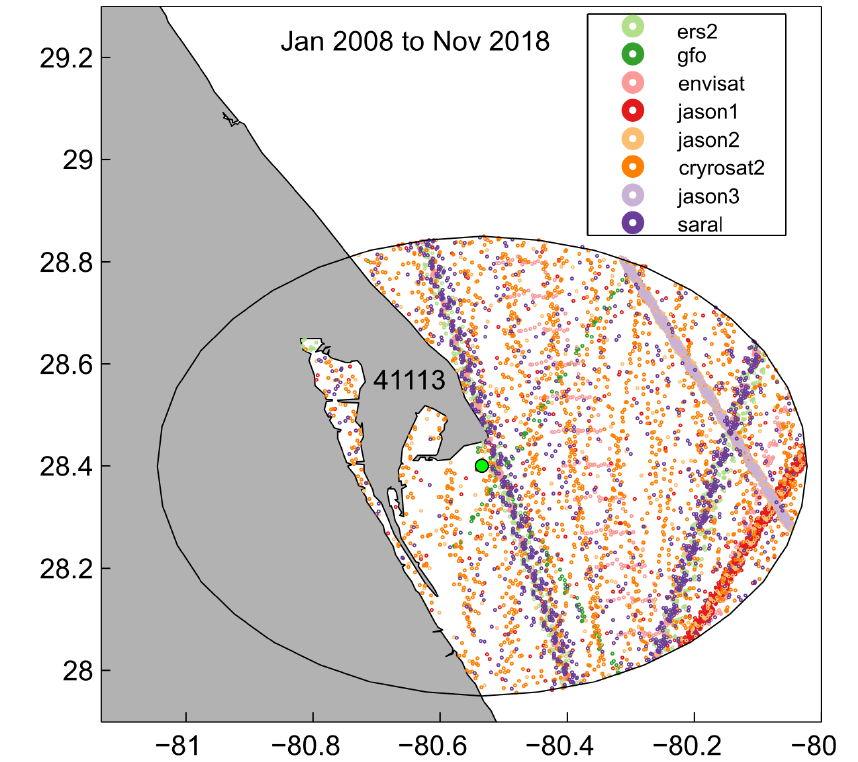
Figure 4. Spatial distribution of satellite tracks contributing to Hs measurements within a 50 km radius of buoy 41113 (region